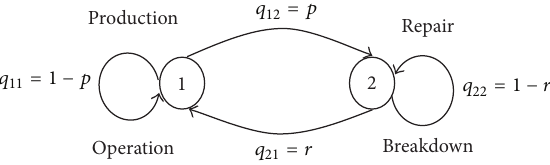
Figure 2: States transition diagram of the system studied.